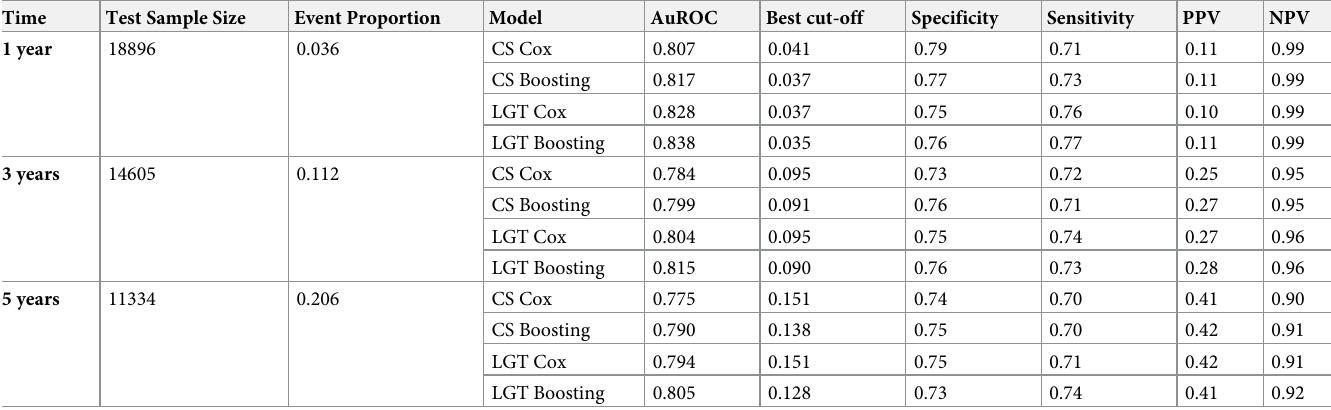
Table 4. Misclassification Table.